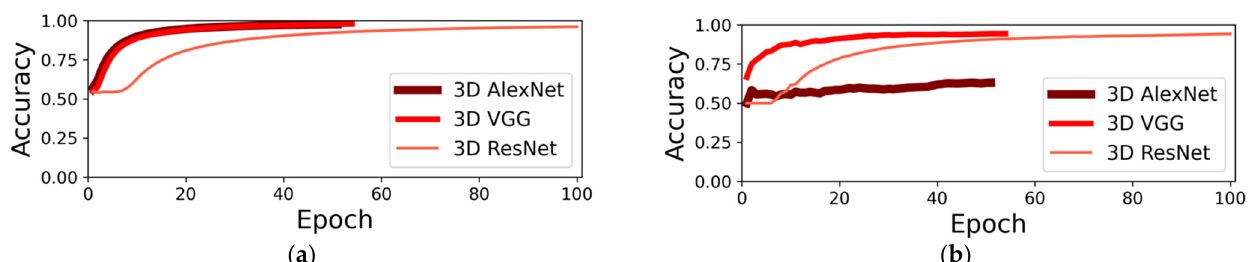
Figure A1. Average training ( a ) and validation ( b ) accuracy for all three networks across the training epochs. Each training is plotted up to the selected best epoch. The selected 3D ResNet trained for 100 epochs, while 3D VGG and 3D AlexNet trained 54 and 51 epochs, respectively. The 3D VGG and 3D ResNet both reached a high validation accuracy at conver- gence.